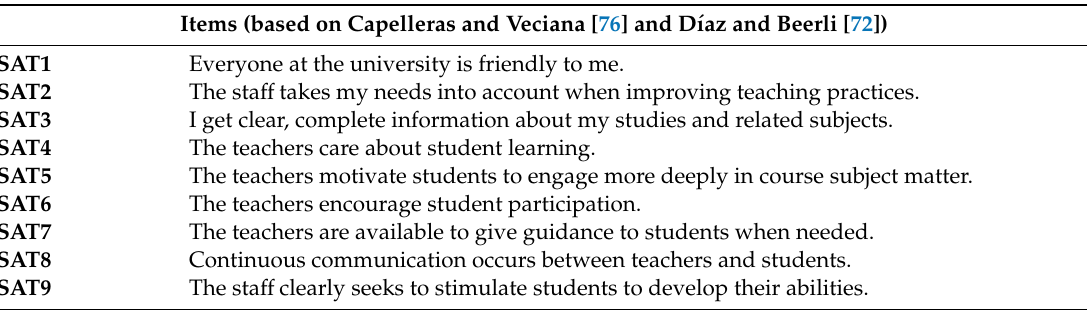
Table A3. Indicators of Student Satisfaction.